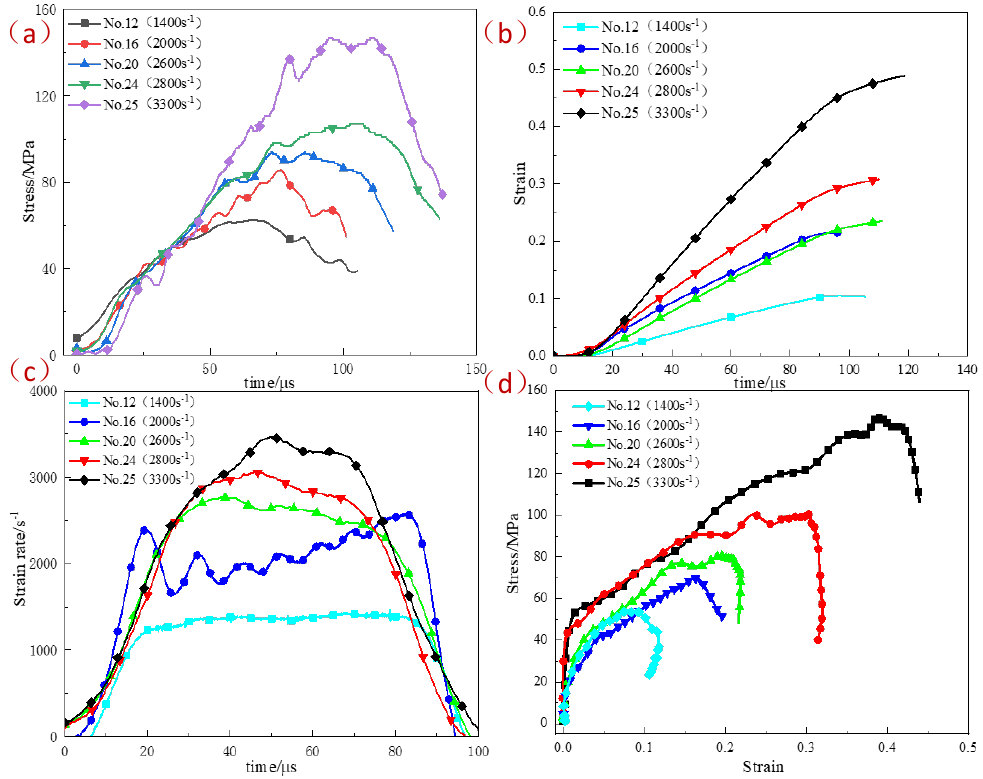
Figure 6. Experimental results of the reinforced Al/PTFE specimens under different strain rates at room temperature. ( a ) Stress–time curve; ( b ) strain–time curve; ( c ) strain rate–time curve; ( d ) stress– strain curve.